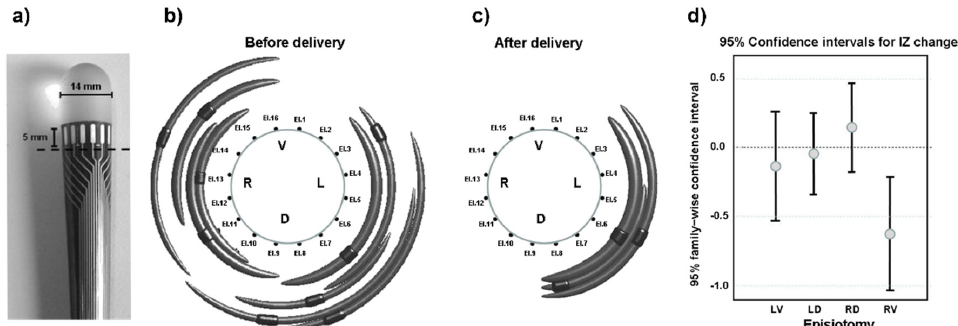
Figure 22. A study of the anal sphincter pre- and post-episiotomy: ( a ) the anal probe with 16 silver electrodes equi-spaced along the circumference; the detection of the innervation zones (IZs) in the same woman before ( b ) and after ( c ) delivery with episiotomy. The black cylinders represent the neuromuscular junctions and the gray arcs depict the identified motor units (MUs). In this subject, no MUs were detected on the side where the episiotomy was performed. The results from 82 cases of episiotomy are shown in ( d ). Fewer MUs were detected on the right ventral (RV) quadrant, where the episiotomies were performed, suggesting damage to the innervation following surgery. Note: the information collected before the delivery was not used to plan the surgery. Quadrants: LV, left ventral; LD, left dorsal; RD, right dorsal; RV, right ventral. Adapted with permission from Figures 1, 2, and 4 from Ref. [45]. Copyright The International Urogynecological Association,